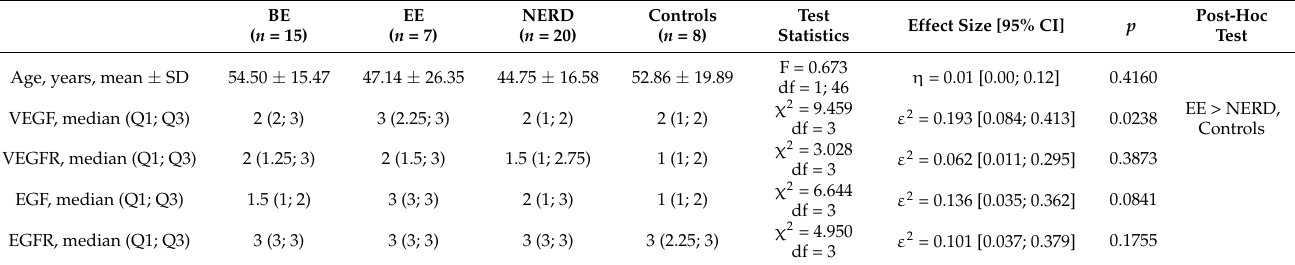
Table 1. Age and expression of VEGF, VEGFR, EGF, and EGFR in the study groups.